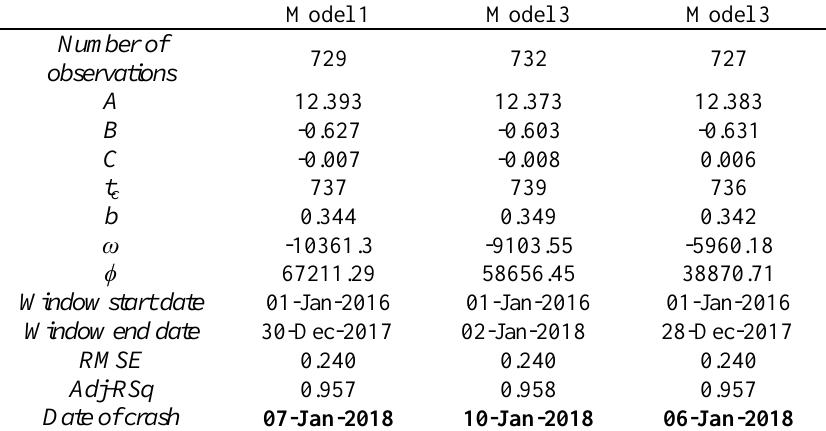
Table 10 : The best fit for CRIX’s LPPL